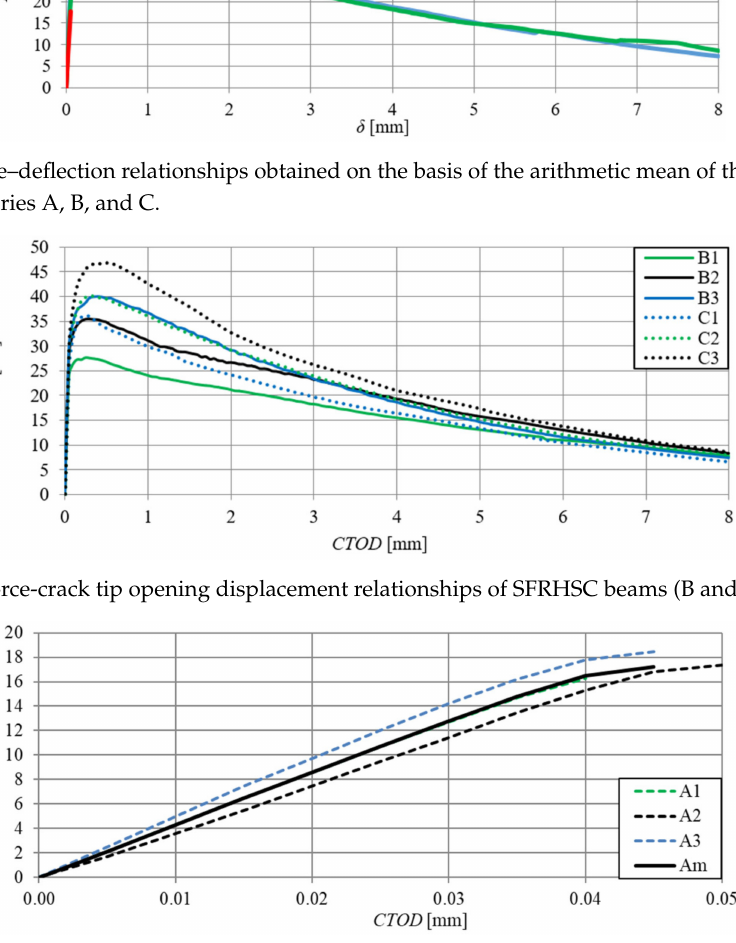
Figure 10. Force-crack tip opening displacement relationships of HSC beams (series A) and the F–CTOD curve obtained on the basis of the arithmetic mean of the results (continuous line, curve A1 coincides with curve Am).